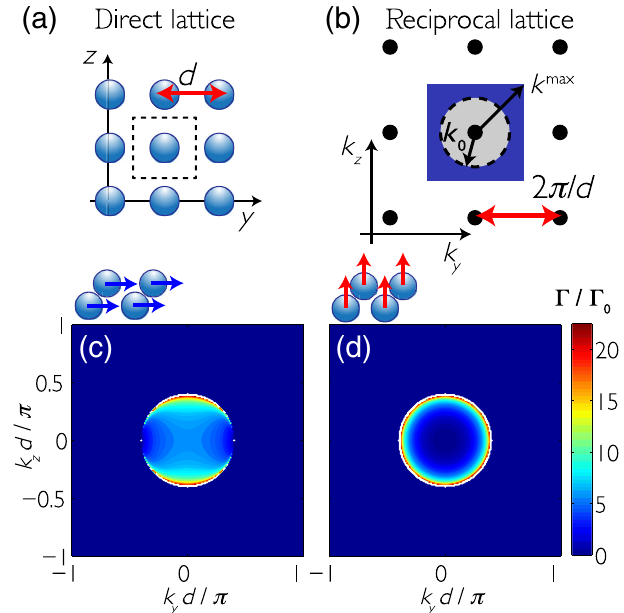
FIG. 2. (a) Illustration of a square lattice of atoms in the ˆ y - ˆ z plane, with lattice constant d . (b) Corresponding reciprocal lattice in 2D, with lattice constant 2 π =d . The collective modes have ; k well-defined quasimomentum k ¼ ð k within the first y z Þ Brillouin zone, which is indicated by the blue square. A circle of radius j k j ¼ k 0 defines the set of propagating electromagnetic modes in vacuum in the ˆ y - ˆ z plane at the atomic frequency. Collective spin waves outside of this circle will be guided, with ffiffiffi p 0 . For k 2 π =d (or equivalently, a decay rate Γ ffiffiffi 0 > k max ¼ k ¼ p 2 d= λ 0 > 1 = ) all collective eigenstates lie inside of the circle. (c),(d) Collective decay rates for the infinite square lattice for parallel and transverse atomic linear polarization, respectively. The lattice constant is set to d= λ 0 ¼ 0 . 2 . For transverse polariza- tion, Γ also vanishes for k ∼ ð 0 ; 0 Þ , provided that d= λ 0 < 1 k